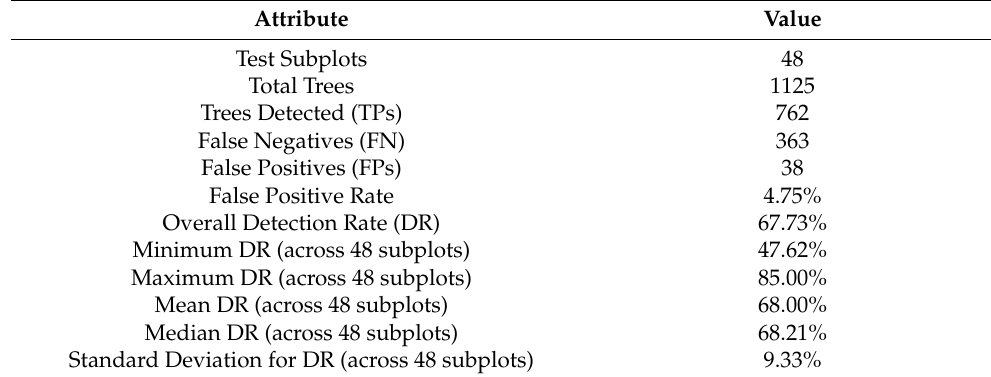
Table 2. Summary statistics for detection rate across the 48 study subplots.